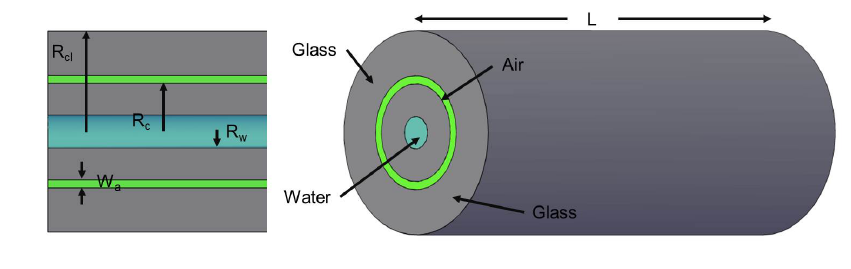
Figure 1. Schematic of the MOF used in the modeling, including labels for the materials and